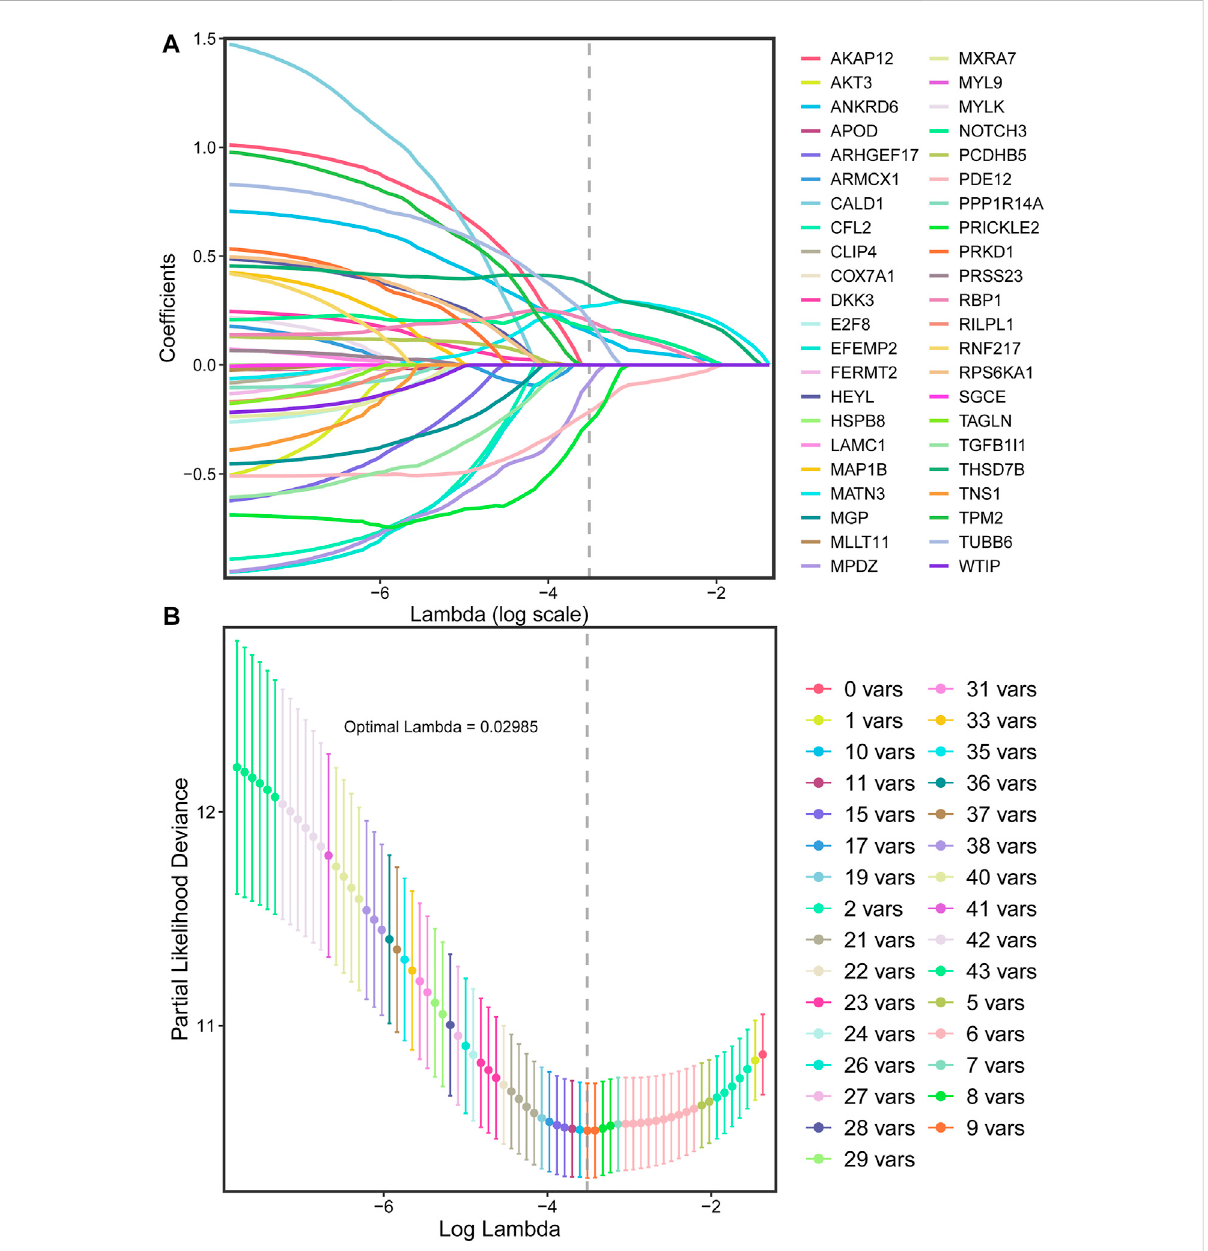
FIGURE 2 LASSO regression for the selection of prognostic genes. (A) , Optimal (minimum) lambda selection for overall survival in the LASSO regression model; (B) , LASSO coef fi cient pro fi les of variables selected for GC patients ’ overall